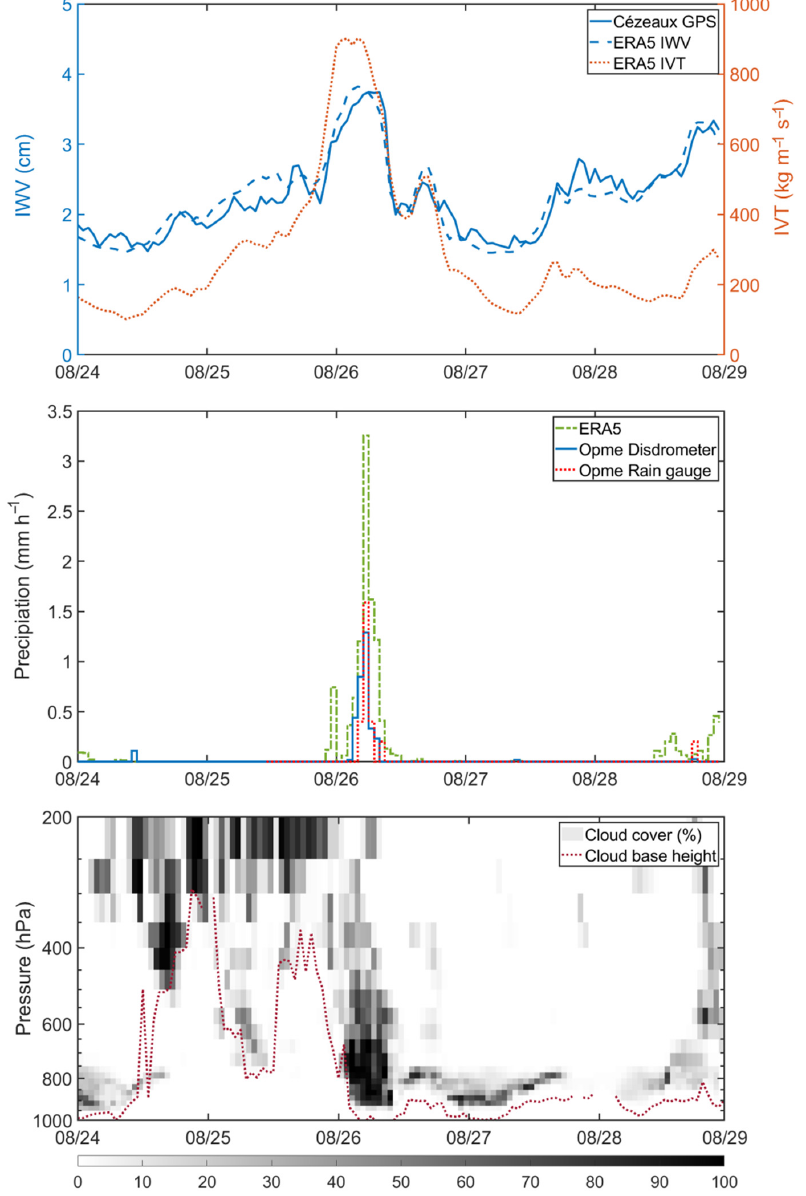
Figure 10. IVT and IWV retrieved by ERA5 and IWV retrieved by GPS at Cézeaux ( top ); hourly precipitation accumulation from ERA5, disdrometer and rain gauge at Opme ( middle ); cloud cover and cloud base height (ECMWF ERA5, bottom ). The interpolation location of ERA5 is 3°E, 45.75°N. The IWV and IVT signals were intense when the AR crossed over the weather station (from 25 August at 21 UT to 26 August at 09 UT). The peak of IVT values were immedi- ately followed by moderate precipitation retrieved by the disdrometer and the rain gauge (peak at 1.5 mm h − 1 on 26 August at 00 UT). This peak of precipitation could also be seen by ERA5, but with much greater quantities. This difference in intensity can be explained by the resolution of the re-analysis, and the very local character of precipitation. It must be noticed that the correspondence between the peak in IWV and a subsequent precipita- tion event has already been documented with a statistical approach [45]. Finally, the cloud